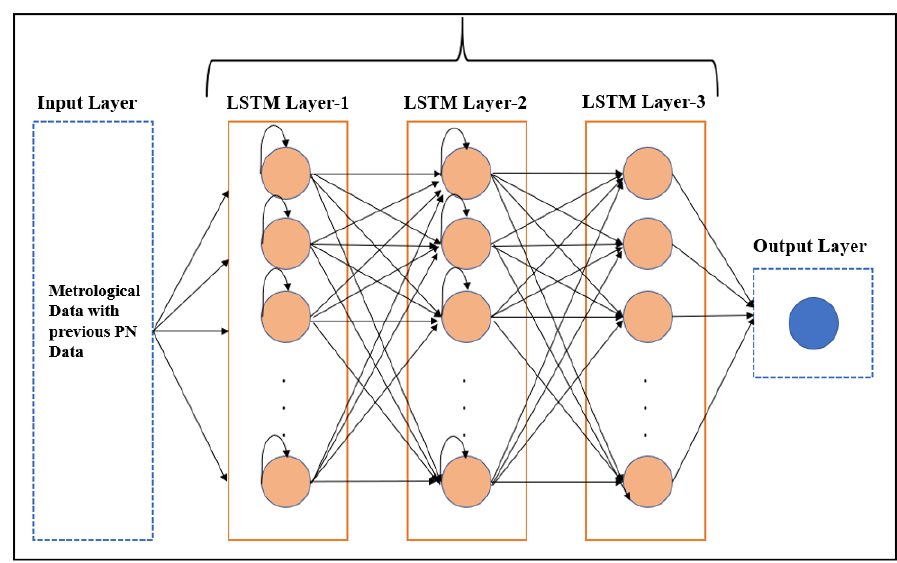
Figure 4. Sequential Long Short-Term Memory (LSTM)